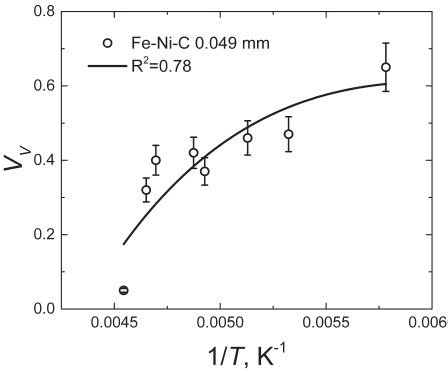
Fig. 4 – Volume fraction of martensite plates per unit of volume against transformation temperature. Fe-31wt%Ni-0.02wt%C alloy 30 with a mean intercept length of austenite grains equal to 0.049 mm. Solid line corresponds to the model developed here: equation 9. Error bars corresponding to an estimated relative error of ±10% were added to the